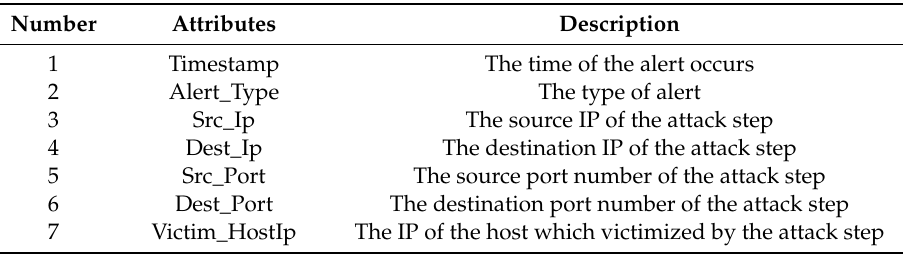
Table 1. The attributes of Advanced Persistent Threat (APT) alert class.